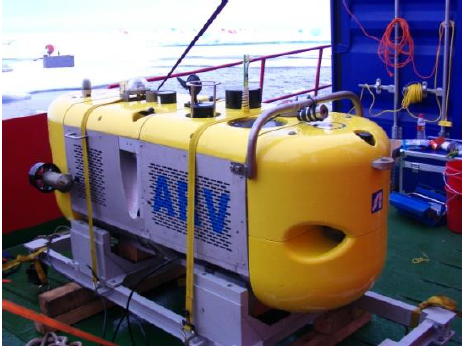
Figure 1. The physical display photo of the “Arctic AUV”.